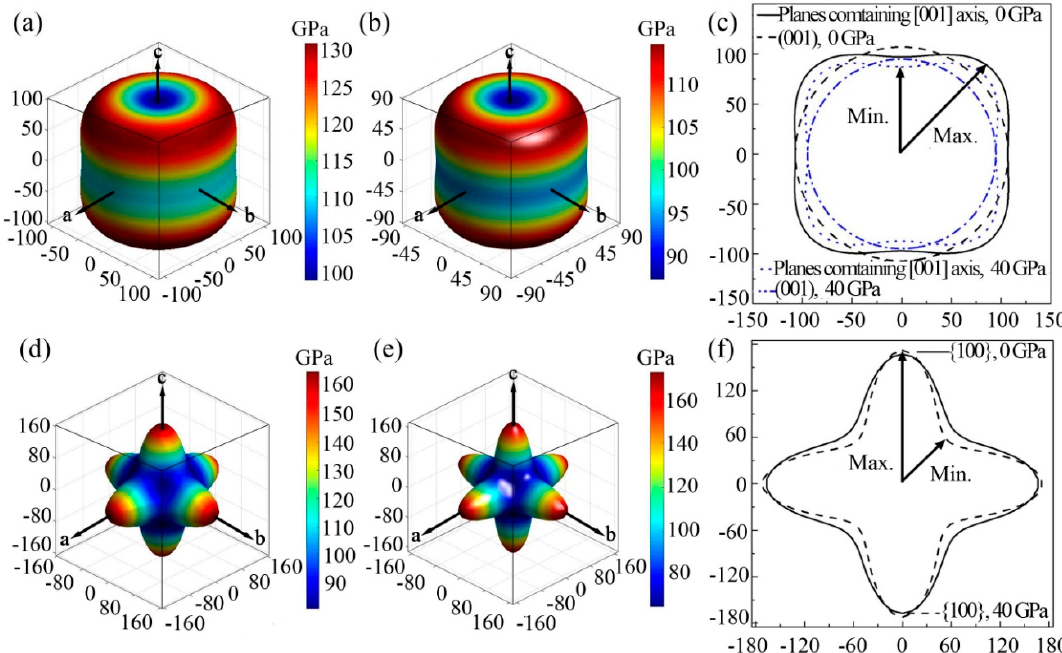
Figure 5. Direction dependences of the shear moduli of: ( a ) wurtzite GaN, 0 GPa; ( b ) wurtzite GaN, 40 GPa; ( c ) projections on main crystal planes, wurtzite GaN; ( d ) zinc-blende GaN, 0 GPa; ( e ) zinc-blende GaN, 40 GPa; ( f ) projections on main crystal planes, zinc-blende GaN.